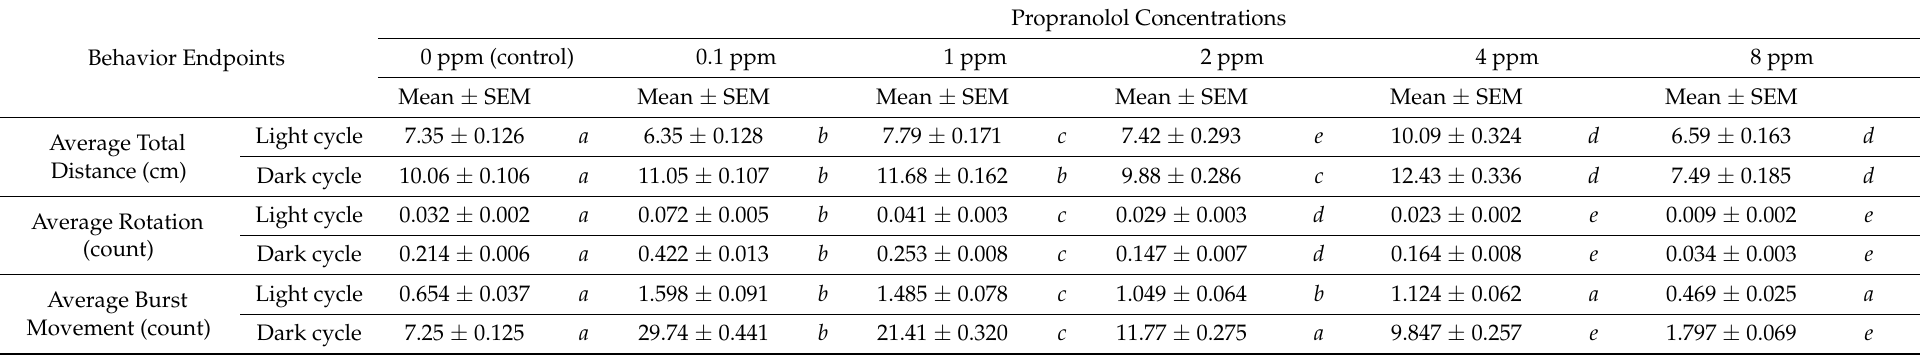
Table A1. Comparison of zebrafish larvae locomotor activity endpoints after treated with 5 different doses of